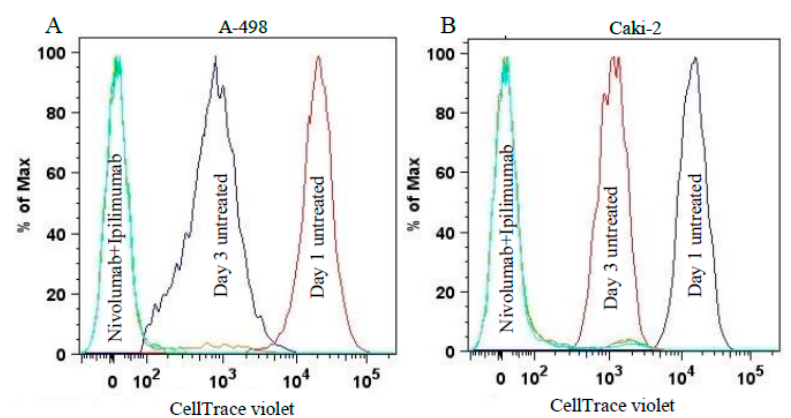
Figure 10. Proliferation of renal cells labeled with CellTrace violet after 72 h of a monoculture and coculture with CIK cells treated with nivolumab and ipilimumab. ( A ) Histogram of the A-498 mono- and coculture with CIK cells. ( B ) Histogram of the Caki-2 mono- and coculture with CIK cells.